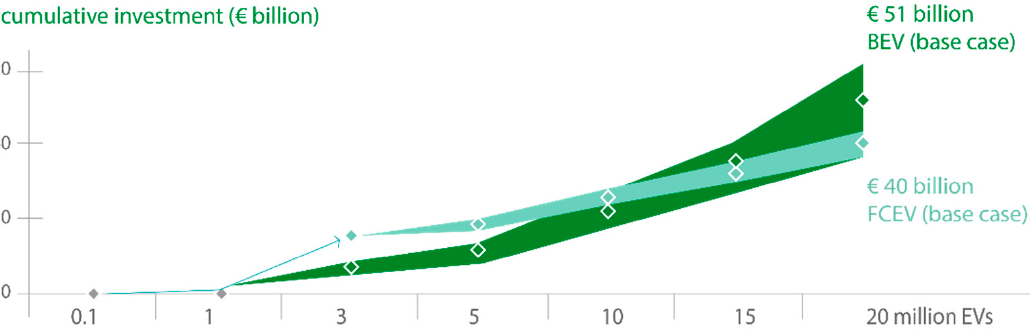
Figure 2. Comparison of the investment for the charging/supply infrastructures BEV and FCEV [7].